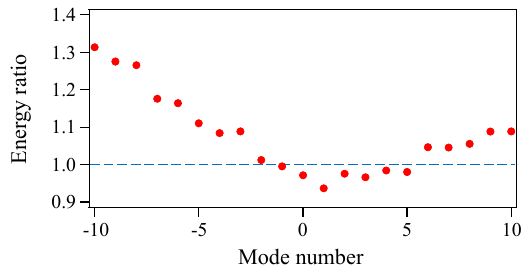
Figure 7. Ratio of pulse energy at each mode in Figure 6c to that in Figure 2b.